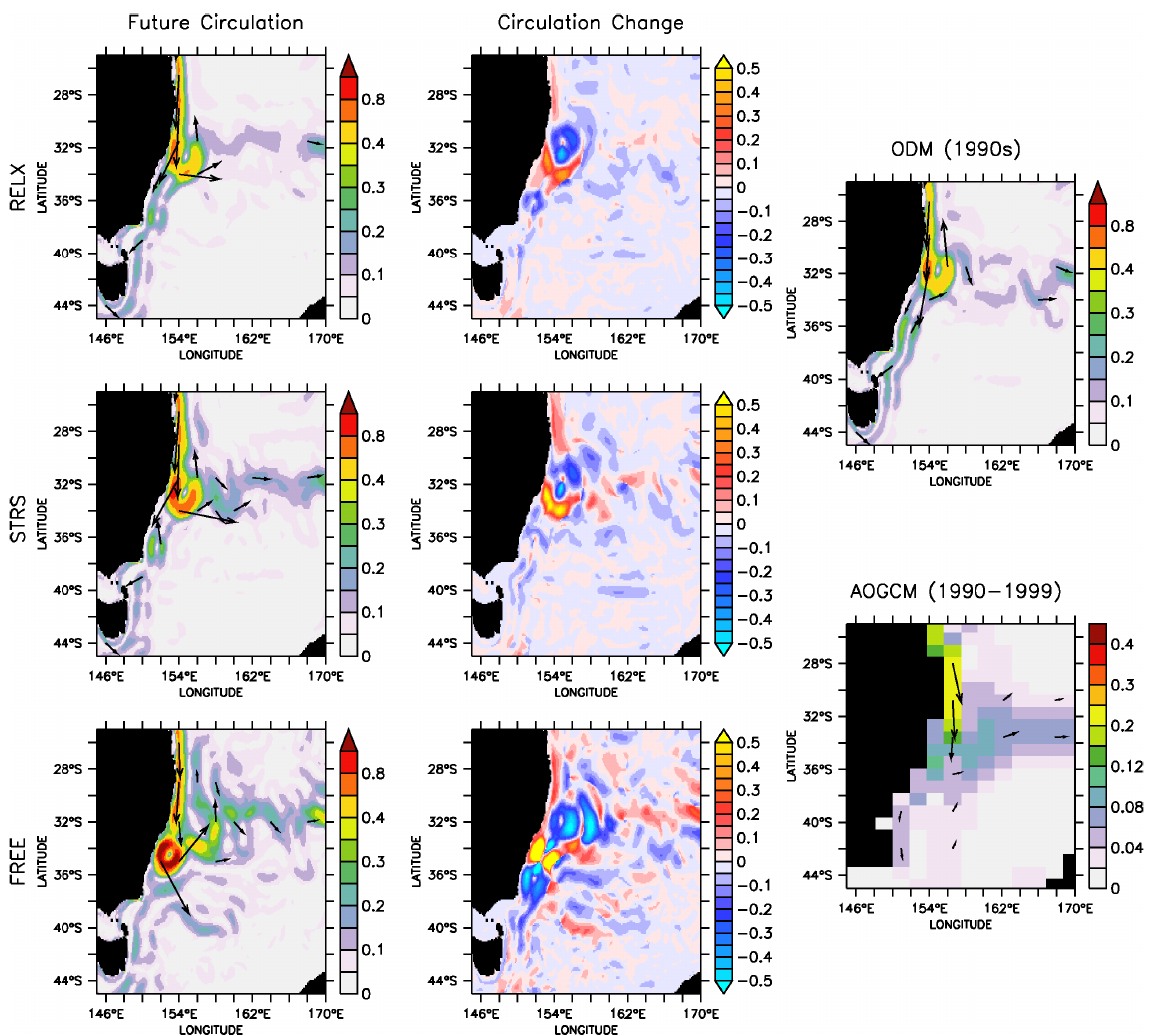
Fig. 13. The average current over the top 250m, in ms − 1 , is used here as a proxy for transport; colours indicate magnitudes, arrows show direction. Multi-year averages are shown of: transport in the upper ocean from the ODM (left column), and projected climate change in transport (centre). Transport changes are calculated in the direction of the present-day transport. The RELX experiment is shown along the top (average of 10yr), STRS is in the middle (5yr), and FREE is at the bottom (1yr). For reference, the transport fields for the 1990s in the ODM and AOGCM are shown in the right